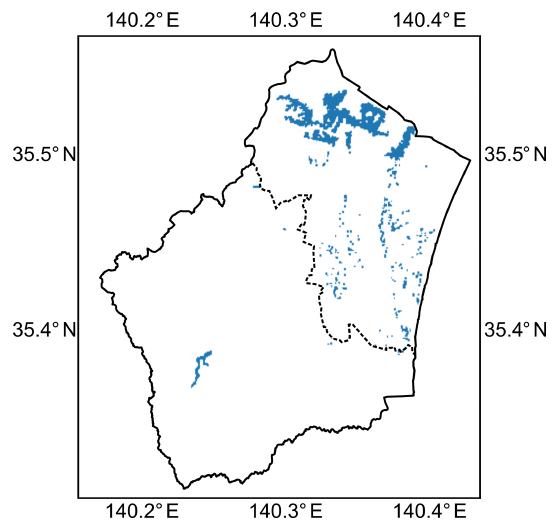
Figure 5. Comparison of the inundation areas by subtracting the inundated locations by T04W case from those by T13W